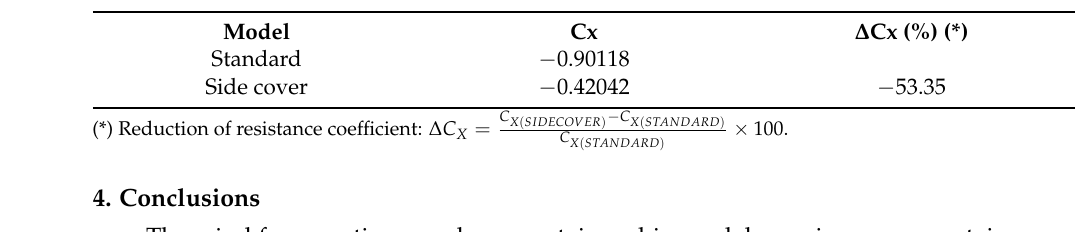
Table 3. Resistance coefficient and reduction of resistance coefficient at a wind direction of 30